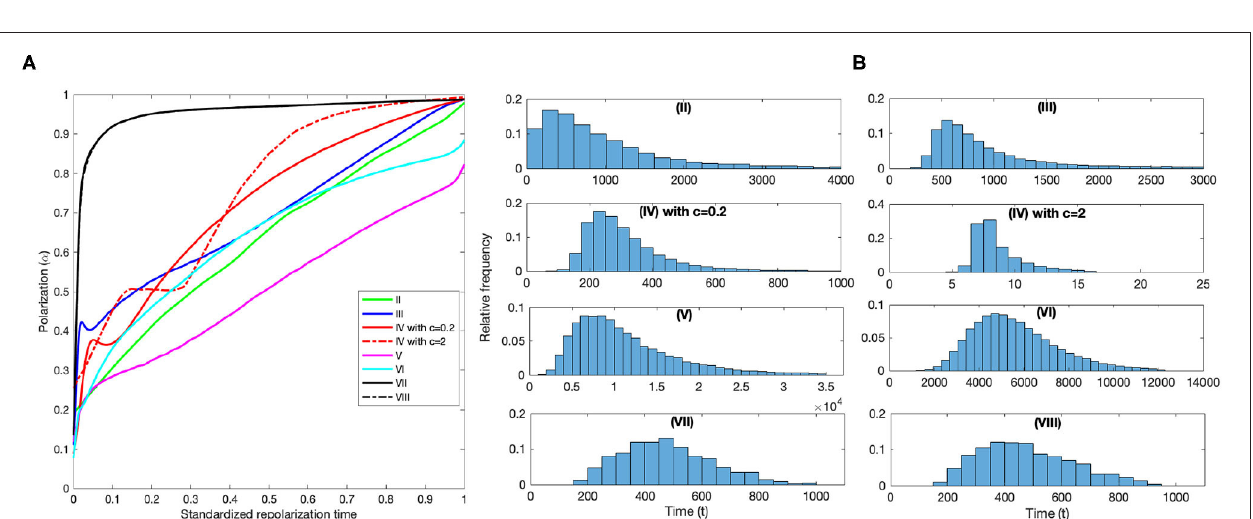
FIGURE 5 | Repolarization processes for the eight models. (A) Median standardized repolarization curves for all models. 0 corresponds to the time the strong perturbation occurred and 1 corresponds to when full polarization was reached. We note that explicit alignment alone (VIII) and in combination with attraction (VII) are virtually indistinguishable, the curves overlap, and they exhibit an exponential repolarization process. We also note that (II) and (III) do start of recovering polarization at an exponential rate, but the process is interrupted and from then on the polarization accumulation for (II) is almost linear, and for (IV) with c = 0.2 moderately superlinear. The curve for (IV) with c = 2 exhibits a similar polarization accumulation process as (IV) with c = 0.2, but the initial accumulation is interrupted later within the repolarization period and the post interruption increase is faster. (II) and (V) effectively accumulate polarization at a linear rate throught the process, and (VI) exhibits a moderately superlinear accumulation. (B) Relative frequency distributions of the (simulation) time to polarization for each model. Here, we can visually confirm the calculated median (simulation) time steps to repolarization for each of the models. (II) 714, (III) 799, (IV with c=0.2) 280, (IV with c = 2) 8, (V) 9853, (VI) 5353, (VII) 466, and (VIII) 460. The main thing to note here is that the median repolarization time of the anticipation with strong attraction model (IV with c = 2) is only 8 time steps. Far faster than the second and third fastest models which repolarize in 466 (VII) and 460 (VIII) time steps,